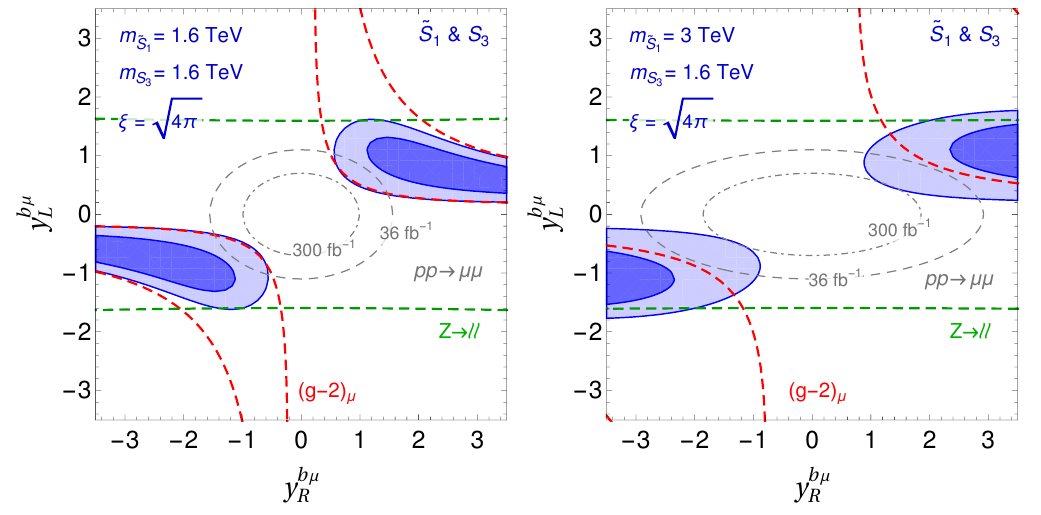
Figure 5 . The values of y b(cid:22) vs. y b(cid:22) for the e S 1 & S 3 scenario with (cid:24) = p 4 (cid:25) that satisfy relevant R L flavor constraints and address ( g 2) (cid:22) through the bottom-quark loops are shown in dark (light) (cid:0) blue to 1 (cid:27) ( 2 (cid:27) ) accuracy for the mass degenerate and mass non-degenerate cases in the left and right panels, respectively. The individual 2 (cid:27) constraints from the Z -pole observables and ( g are represented with green and red dashed lines, respectively. The (projected) LHC limits from the study of pp (cid:22)(cid:22) at high- p T , at the 2 (cid:27) level, for ( 300 fb (cid:0) 1 ) 36 fb (cid:0) 1 worth of data are shown with ! (dash-dotted) dashed gray lines